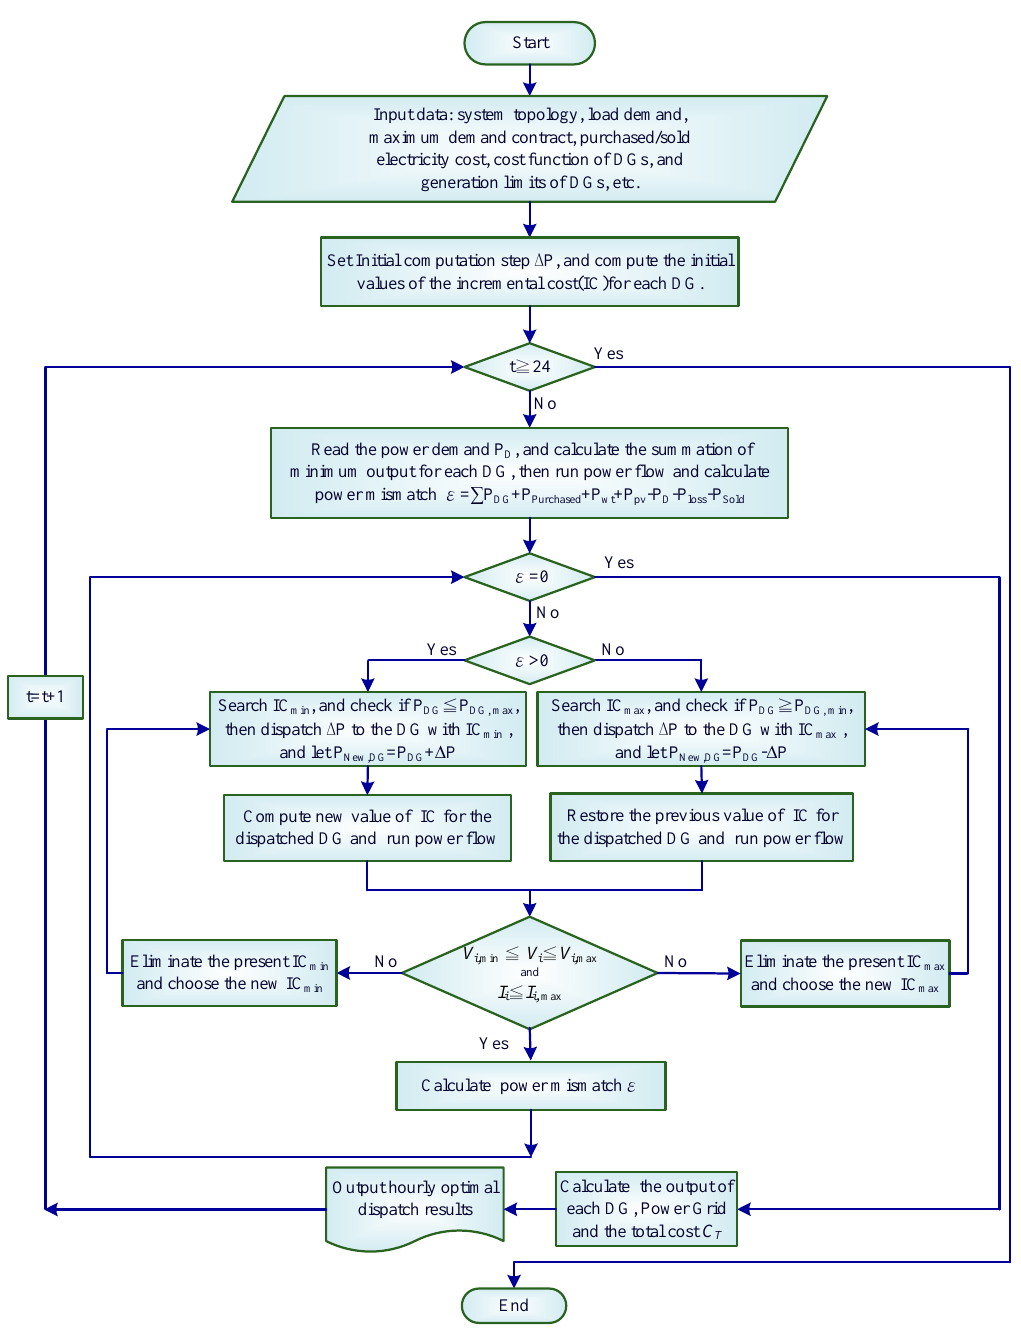
Figure 6. Flow chart of the proposed direct search method